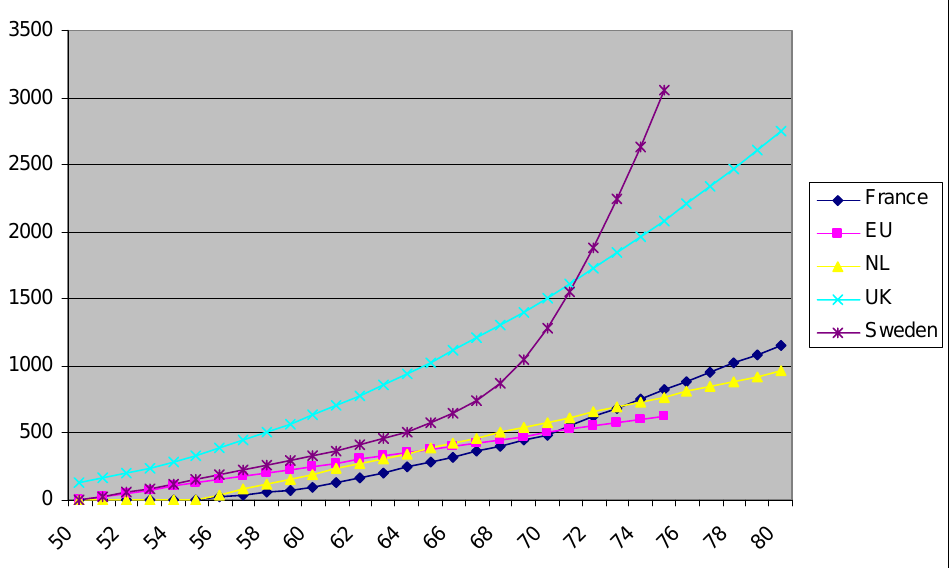
Figure 2. Value (in euros) per noise level per household per year in different European countries and the average EU values for road traffic